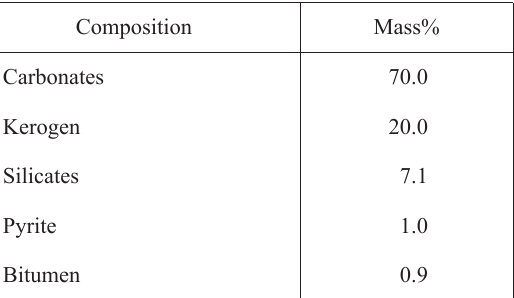
Table 1. Chemical composition of sub-layer R